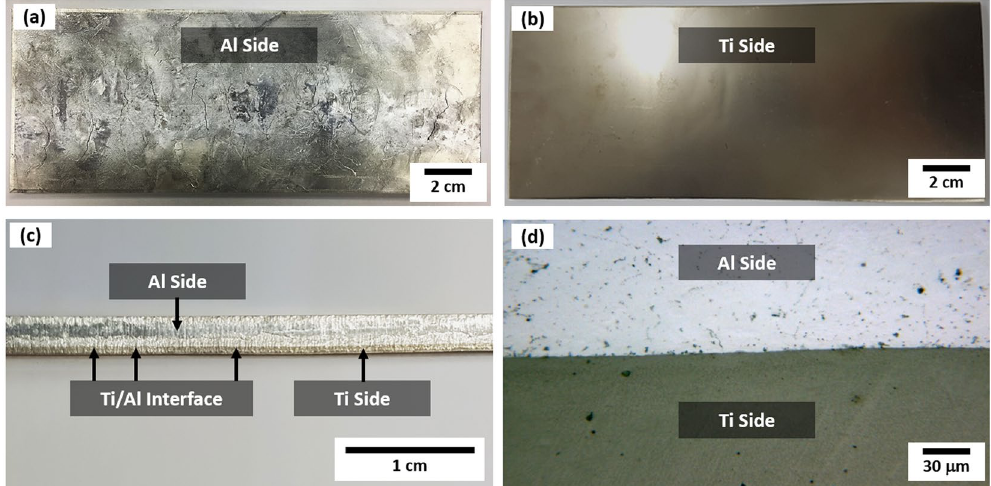
Figure 1. Overall shape of as-twin-roll-cast Ti/Al clad sheet. Low-magnification optical photographs of ( a ) 5052 Al alloy substrate side, ( b ) Ti side, and ( c ) and ( d ) Ti/Al interface of the as-twin-roll-cast Ti/Al clad specimen made by optimum parameters (induction-melting temperature of Al alloy; 680 °C, twin-roll speed; 30 mm/sec, twin-roll gap; 3.0 mm, thickness of pure Ti sheet; 0.5